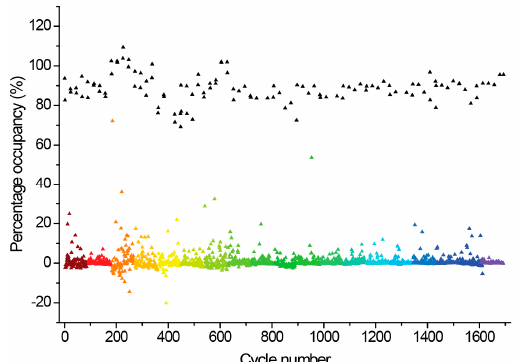
Figure 3. Fragment screening against hAQP1 protein using Surface plasmon resonance (SPR). Screening data adjusted from response unit to percentage surface occupancy, based on equilibrium